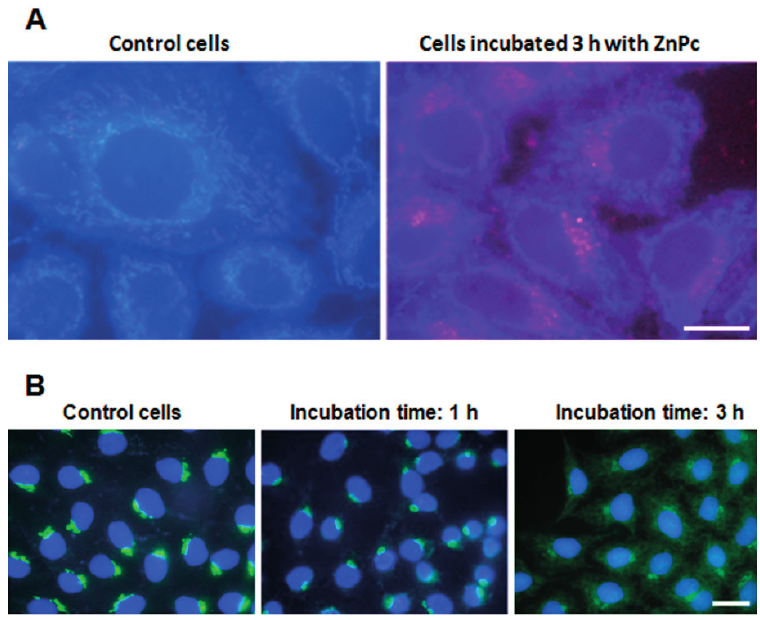
Figure 1. Zinc-phthalocyanine (ZnPc) localization in HeLa cells. ( A ) Control cells and cells incubated with 1 µM ZnPc for 3 h observed in fluorescence microscopy under UV excitation without any processing; ( B ) HeLa cells fixed immediately after photodynamic treatments, processed for indirect immunofluorescence for golgin-130 (GM130), counterstained with Hoechst-33258 (H-33258) and observed in fluorescence microscopy under UV and blue excitation light (overlay image). Scale bar: 20 µm.